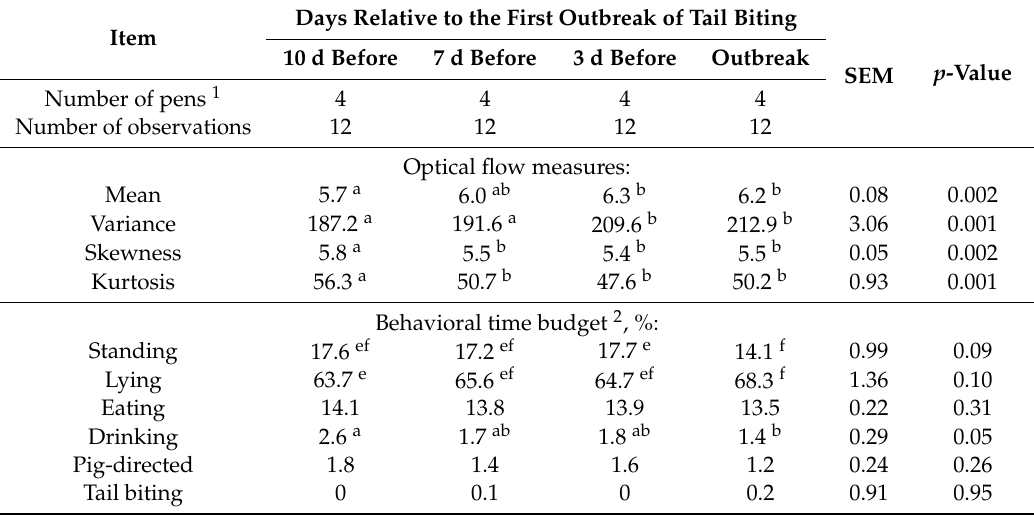
Table 1. Optical flow measures and behavioral time budget for growing-finishing pigs in pens that experienced tail-biting outbreaks during the study